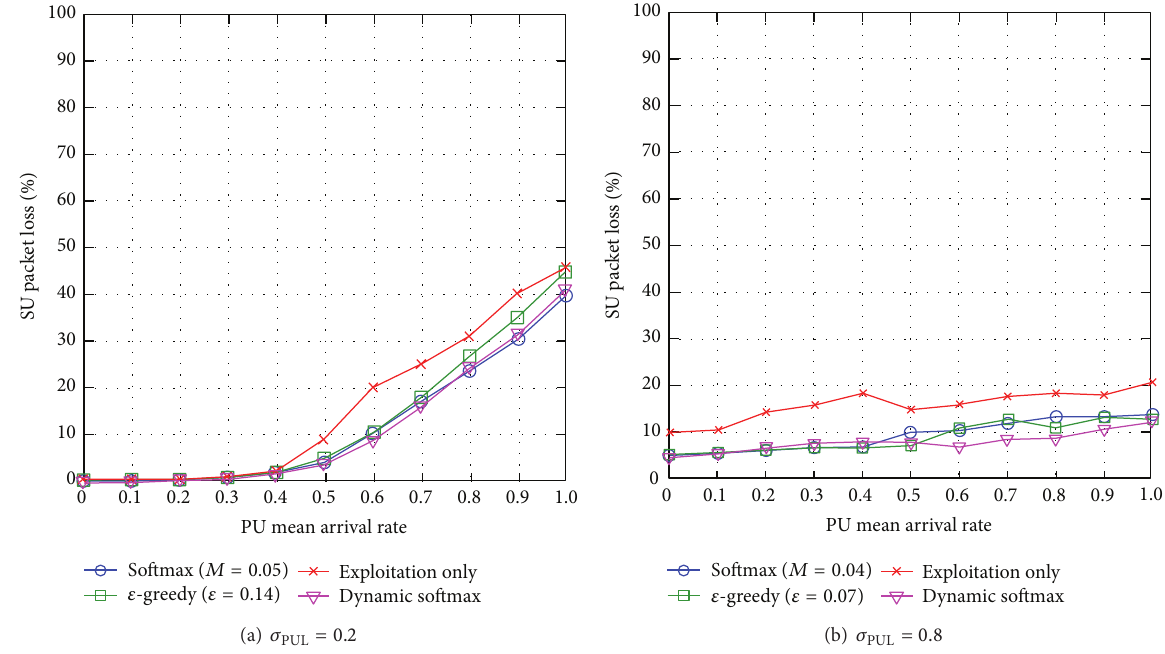
Figure 13: SU packet loss for varying PU mean arrival rate 𝜇